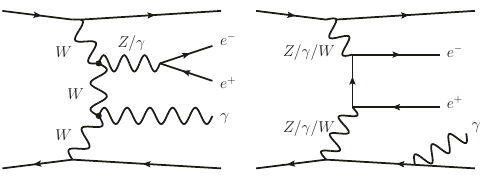
Figure 1 . Representative Feynman diagrams at